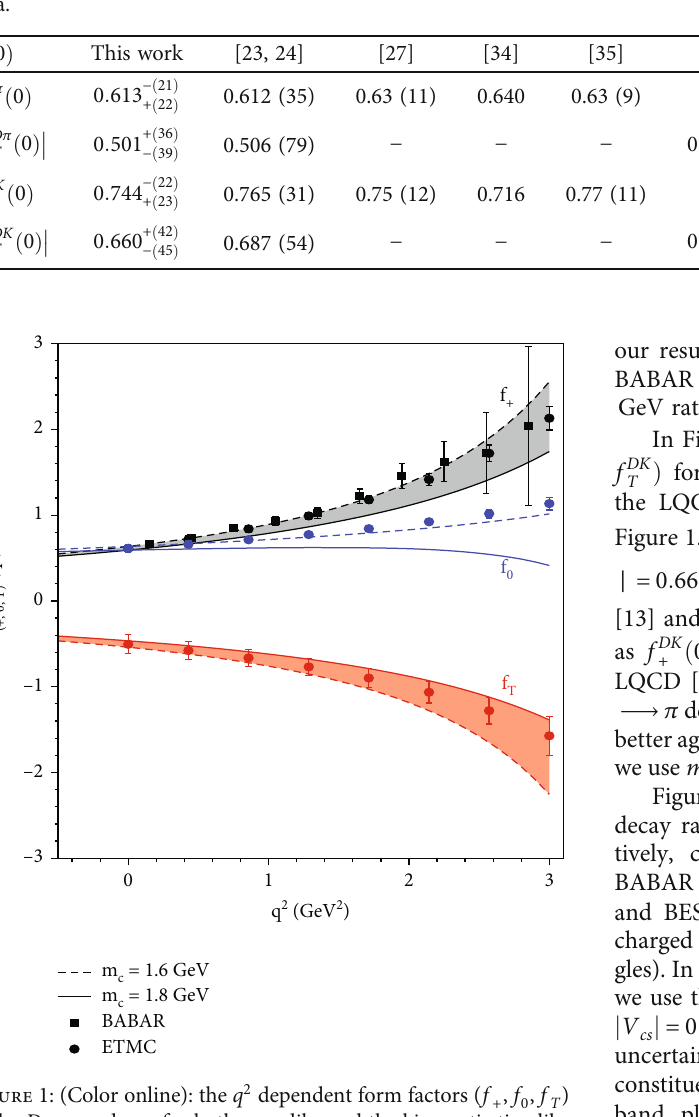
2 GeV 2 . For comparison, the data − M π Þ D